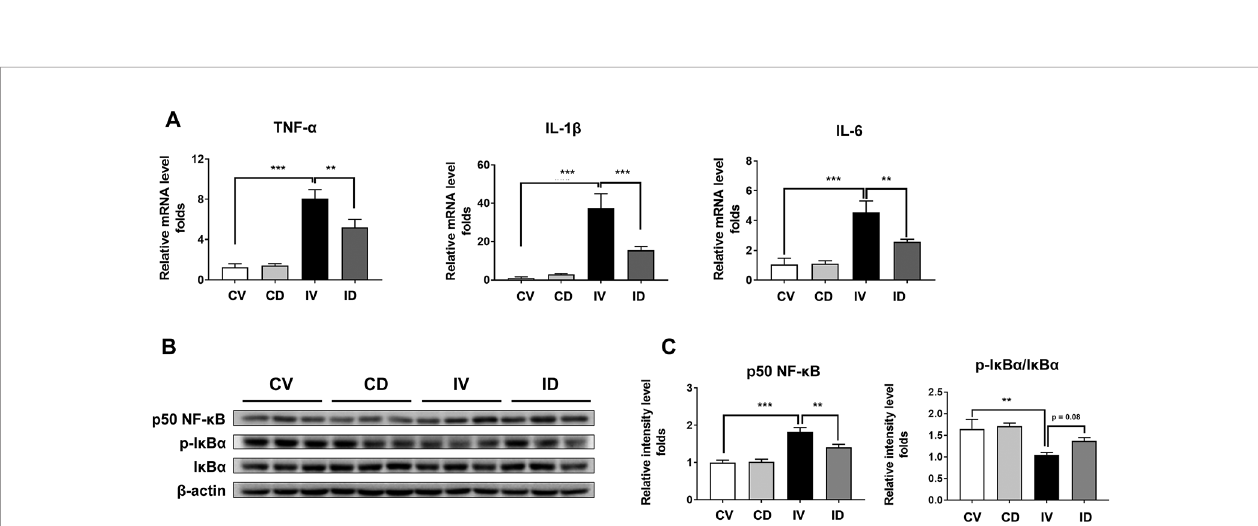
FIGURE 4 | Dulaglutide treatment reduced the expression of proin fl ammatory cytokines and p50 NF- k B in disuse-induced muscle atrophy. (A) The mRNA expression levels of TNF- a , IL-1 b , and IL-6 were analyzed with RT-qPCR in GA muscle tissue. GAPDH mRNA was used as an internal control. (B) Immunoblotting and (C) quanti fi cation analyses of p50 NF- k B and p-I k B a protein expression in GA muscle. Beta-actin was used as a loading control. Data are shown as mean ± S.E.M, n = 5; **p < 0.01 or ***p < 0.001 as compared with control + vehicle or disuse + vehicle group. CV, control + vehicle; CD, control + dulaglutide; IV, immobilization + vehicle; ID, immobilization + dulaglutide.